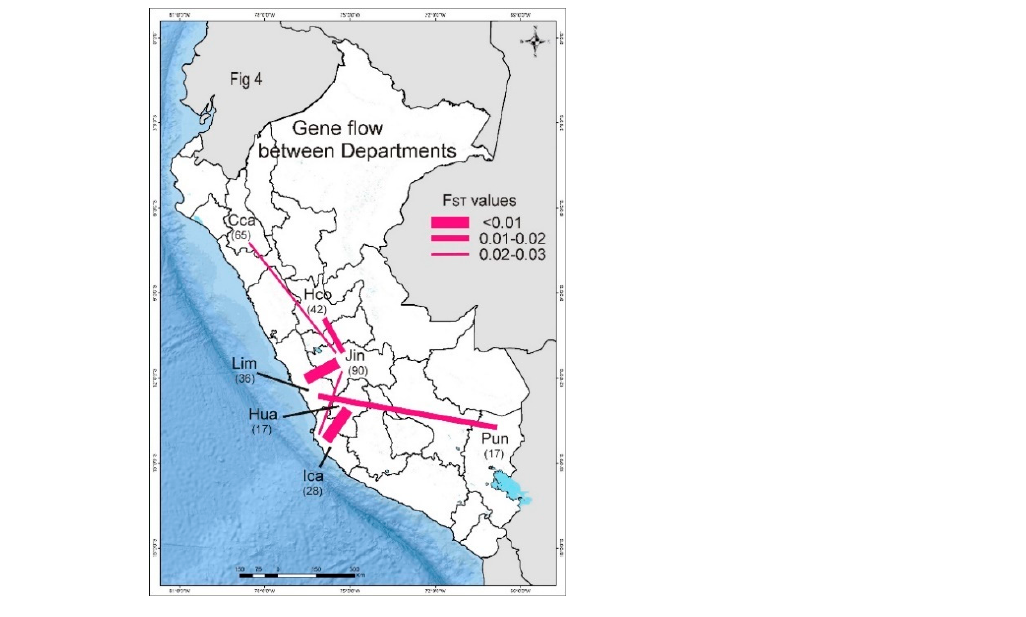
Figure 4. Cartoon showing the most significant genetic linkages between the potato virus X populations of different Peruvian Departments. Linkages are indicated by their F ST values [97,98]. Gene flow between Department populations was assessed using the F ST measure [89,97,98].